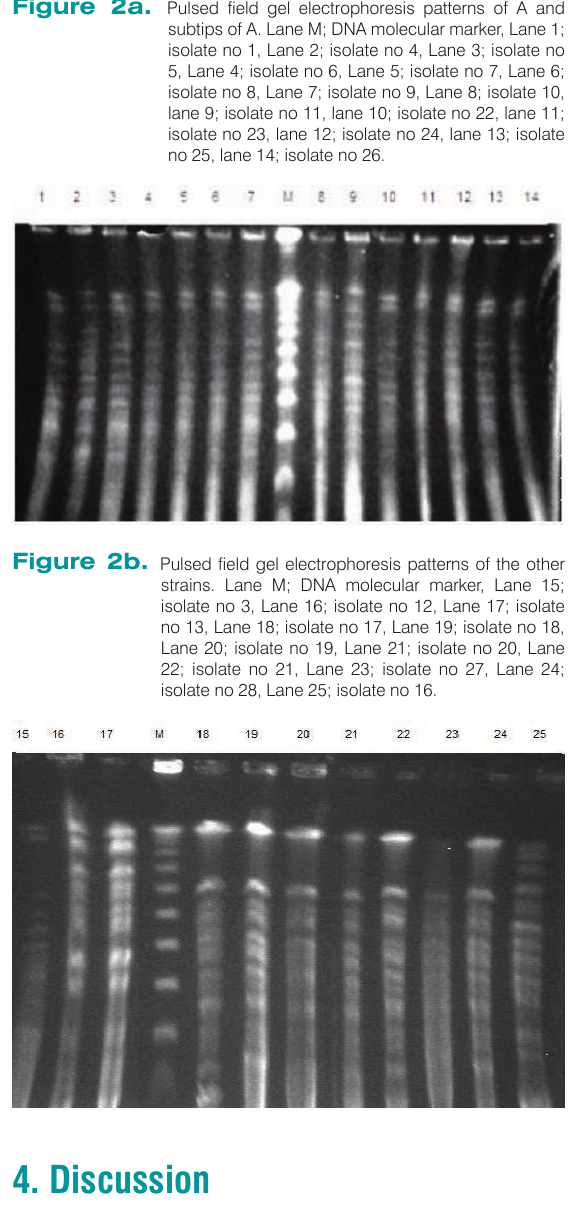
Figure 2a. Pulsed field gel electrophoresis patterns of A and subtips of A. Lane M; DNA molecular marker, Lane 1; isolate no 1, Lane 2; isolate no 4, Lane 3; isolate no 5, Lane 4; isolate no 6, Lane 5; isolate no 7, Lane